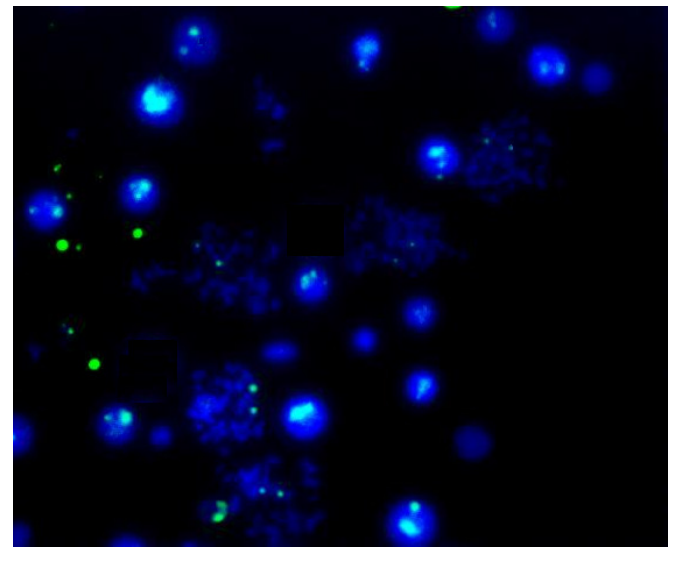
Figure 7. FISH analysis on the FISHprep samples (The FISH signals indicate the presence of two X-chromosomes in the chromosome spreads and